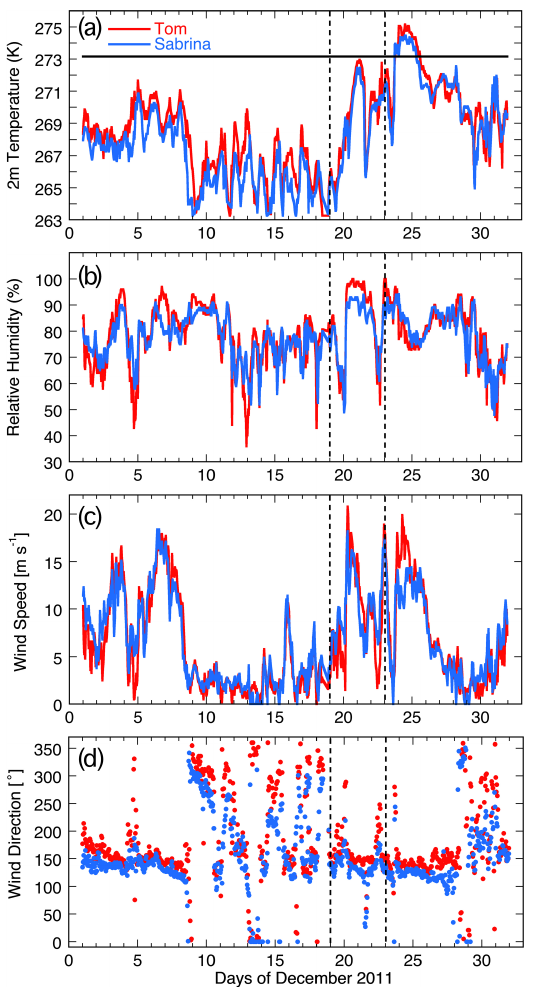
Figure 25. Time series of 2m meteorological measurements from the Tom and Sabrina AWSs throughout December 2011: (a) air tem- perature, (b) relative humidity, (c) wind speed, and (d) wind direc-